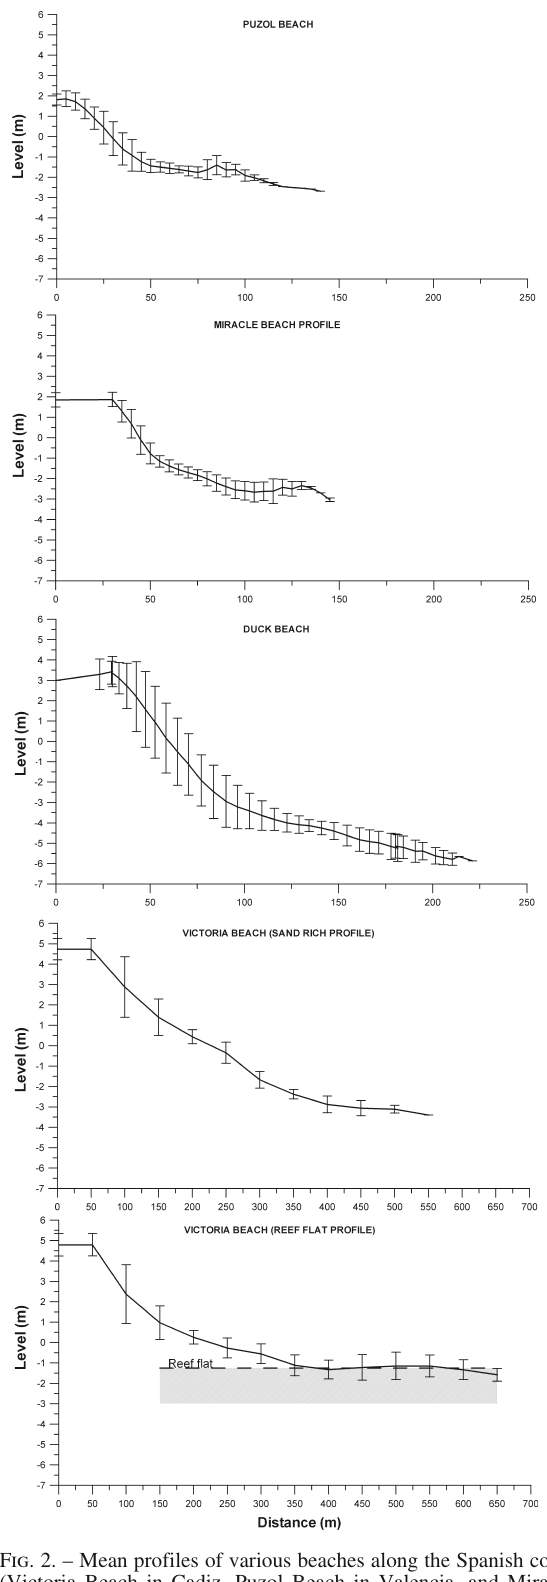
Fig . 2. – Mean profiles of various beaches along the Spanish coast (Victoria Beach in Cadiz, Puzol Beach in Valencia, and Miracle Beach in Tarragona) and the United States Atlantic Coast (Duck Beach in Dare County, North